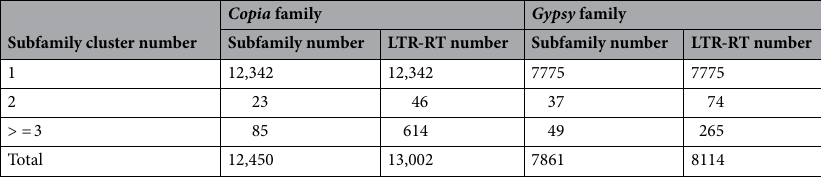
Table 1. Classification of LTRs in different families and